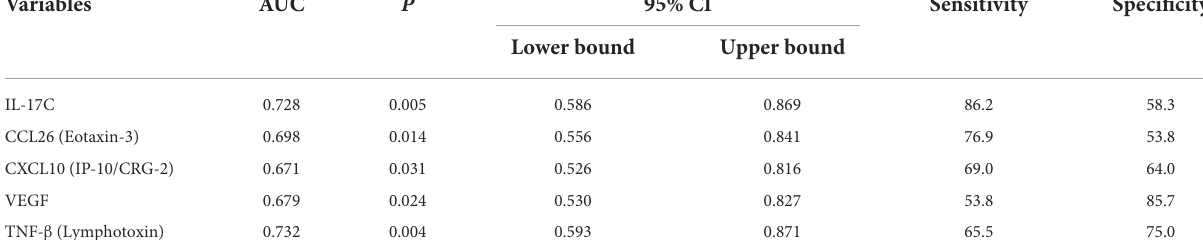
TABLE 4 ROC analysis of different cytokines in discriminating MDD patients with SI from MDD patients without SI.